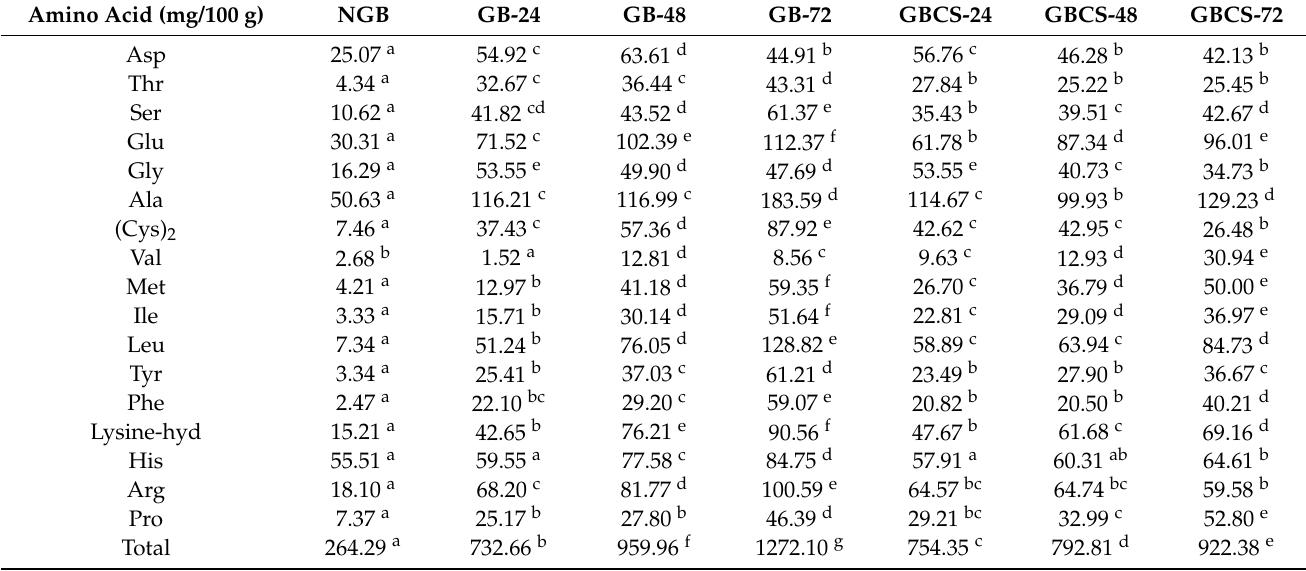
Figure 7. Change in protein content influenced by cold stress and germination. GB, germinated black rice without cold stress; GBCS, germinated black rice under cold stress at 0 ◦ C for 1 h; ( a ) represents the change in protein content influenced by cold stress time; ( b ) represents the change in protein content influenced by germination time with or without cold stress. Means with different small letter superscripts are significantly different at p < 0.05.